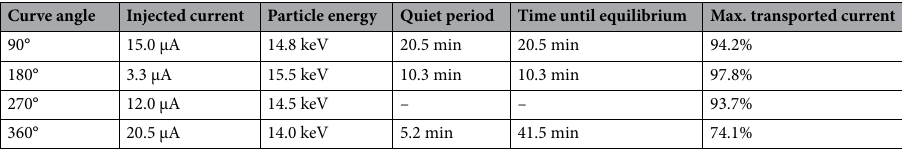
Table 2. Overview of the testing parameters used in the presented electron guiding